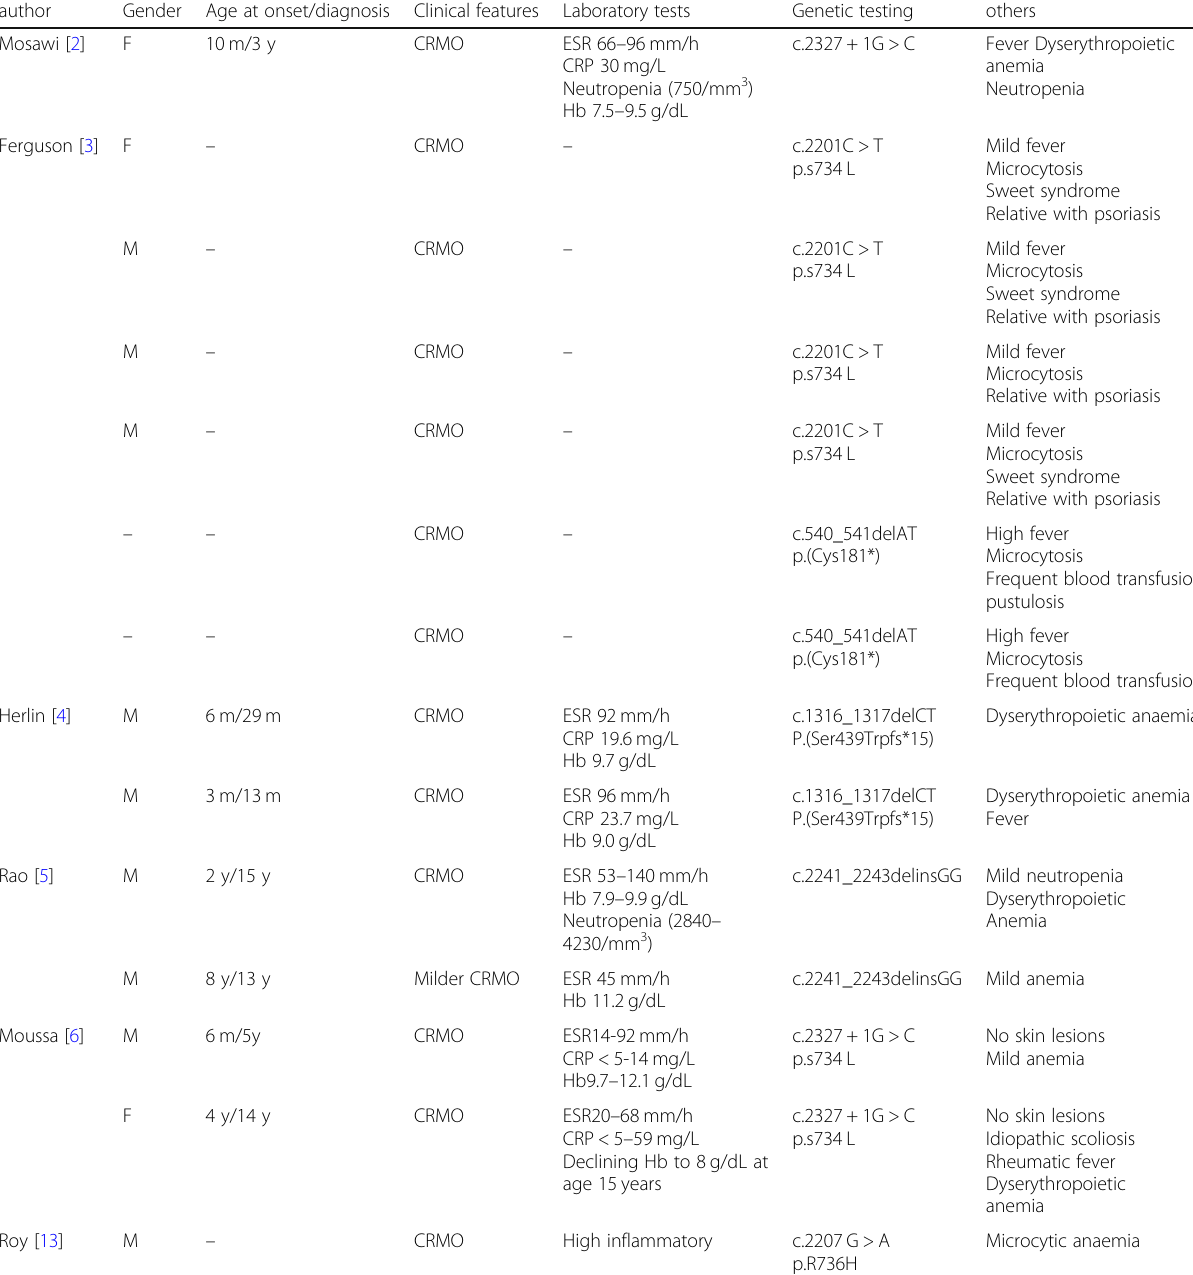
Table 1 Fourteen patients with Majeed syndrome: clinical course and laboratory investigations author Gender Age at onset/diagnosis Clinical features Laboratory tests Genetic